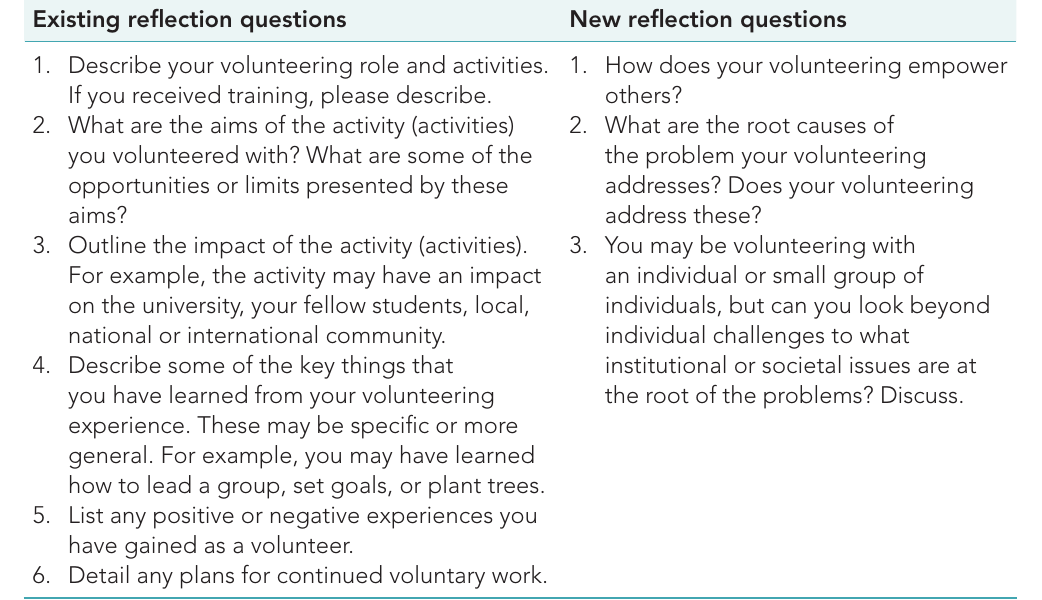
Table 1: ALIVE student volunteer portfolio reflection questions Existing reflection questions New reflection